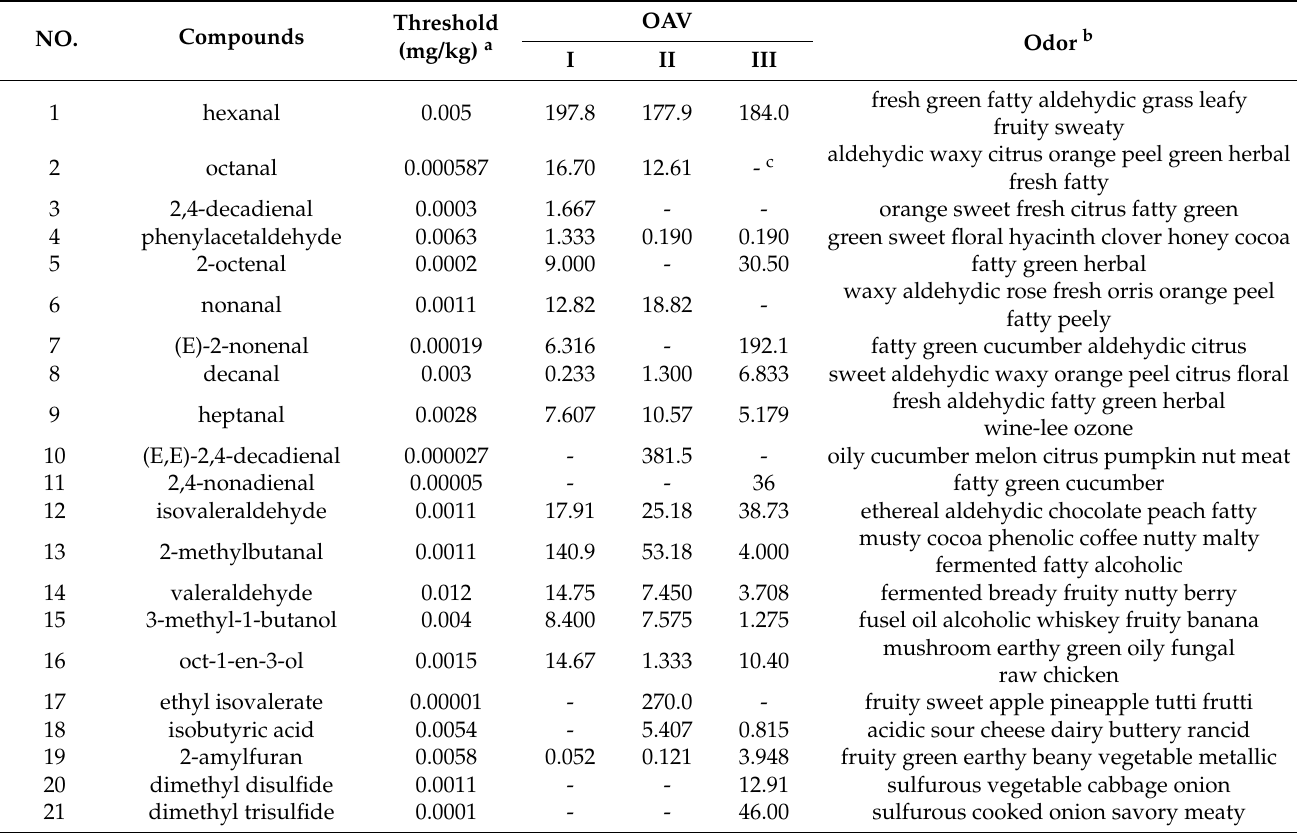
Table 2. Key volatiles with OAV ≥ 1 in